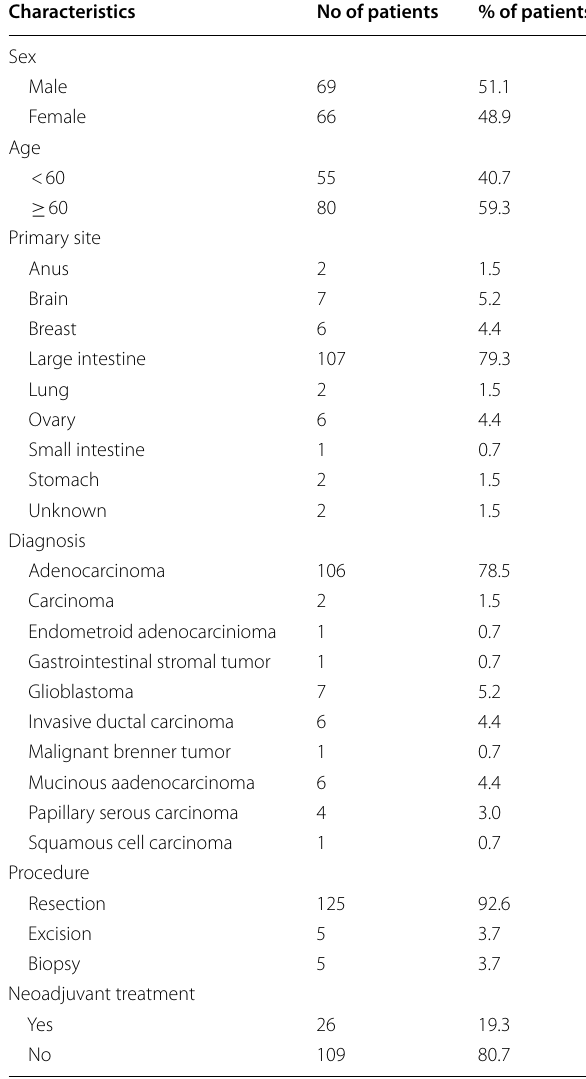
Table 1 Clinicopathologic characteristics of cases Characteristics